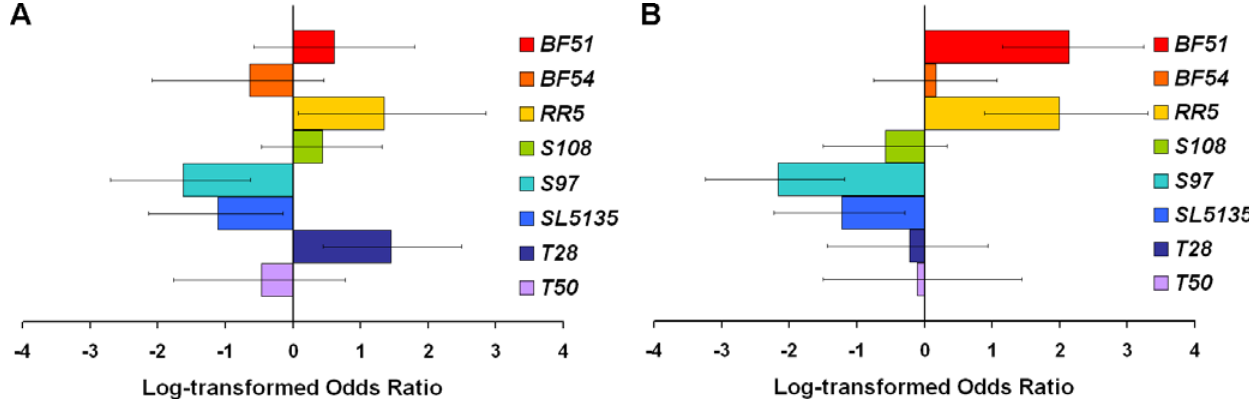
Figure 4. Odds ratios for each line over one of the mth mutants ( mth D 6 or mth 1 ) relative to the line over mth R3 . The comparison using mth D 6 is on the left ( A ); the comparison using mth 1 is on the right ( B ). Positive ratios indicate greater risk of death. The heterogeneity in the magnitude and direction of relative odds represents the functional diversity in stress resistance among the wild mth lines. Error bars show 95% confidence. Error bars which do not cross the y-axis signify a failure to complement in that line.